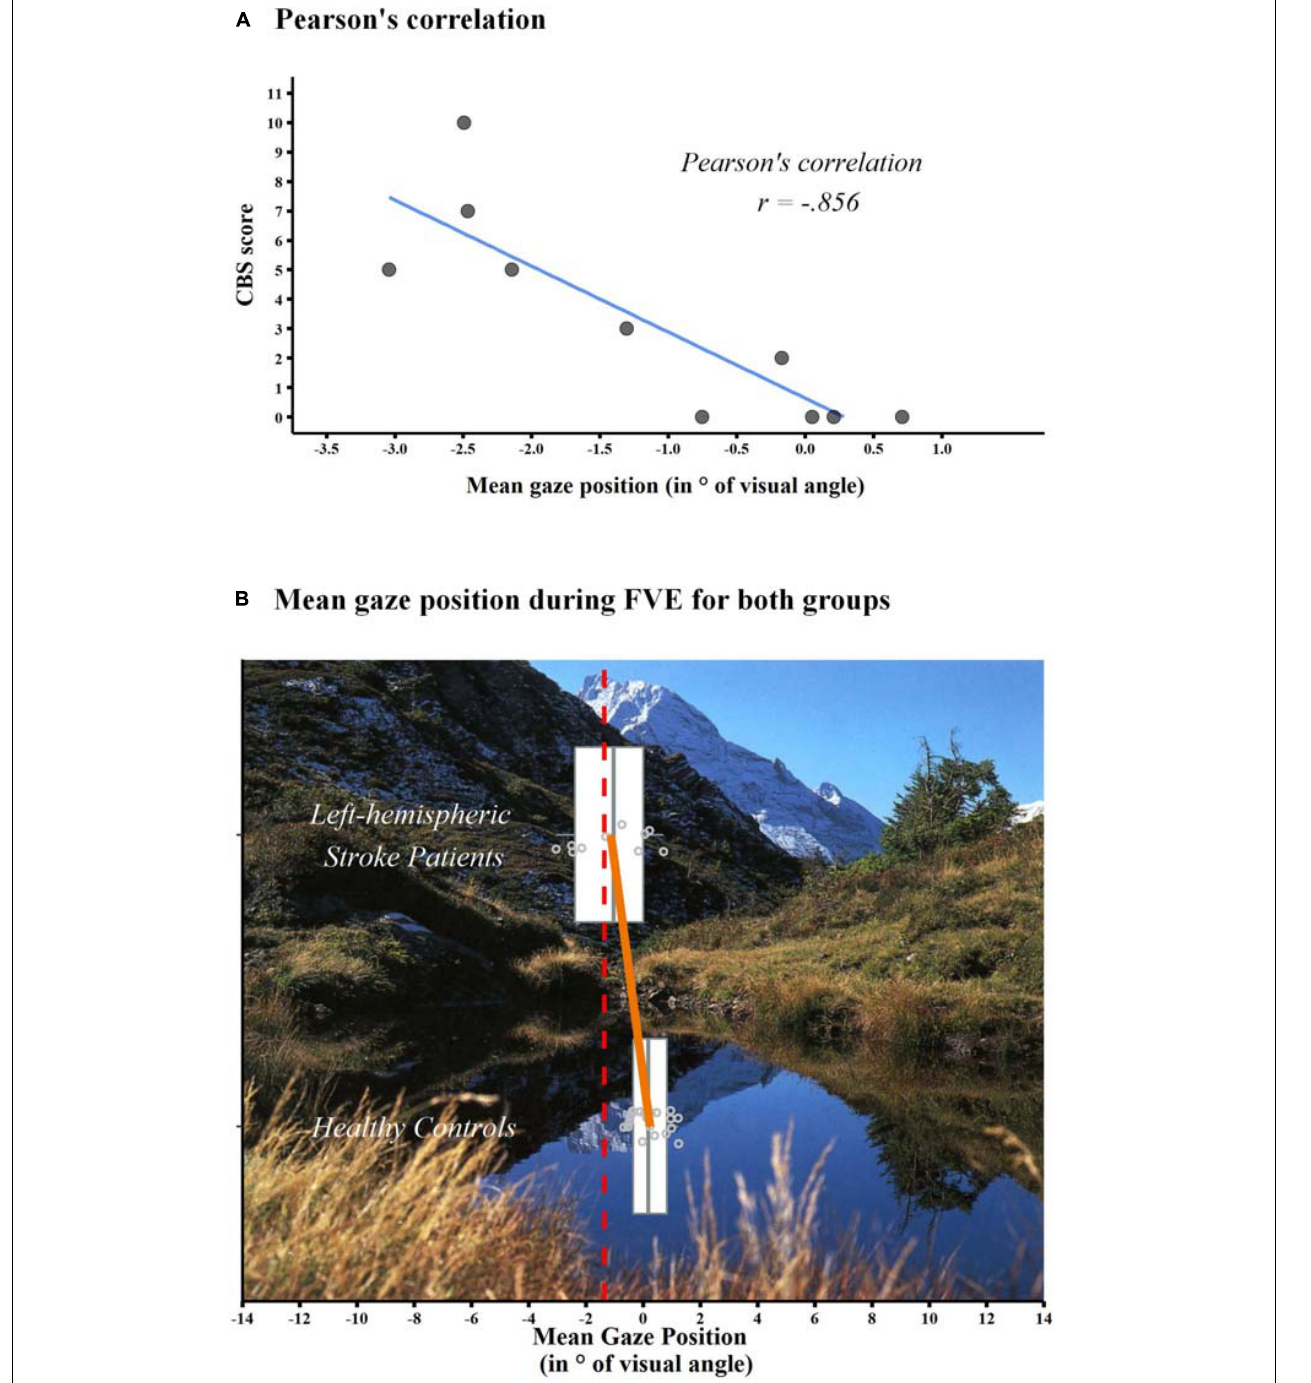
FIGURE 3 | (A) Depiction of the Pearson’s correlation between the mean gaze position during FVE and the CBS total scores in left-hemispheric stroke patients. The regression line is shown in blue. Grey dots represent the patients’ individual CBS total scores ( y -axis) and the corresponding mean gaze position during FVE in ◦ of visual angle ( x -axis; negative values representing a left-ward shift in exploration behaviour). (B) Box-and-Whisker plots of the Mean Horizontal Gaze Position (in ◦ of visual angle) in left-hemispheric stroke patients ( n = 10, top) and healthy controls ( n = 20, bottom). Each box represents the lower (Q1) to the upper (Q3) quartiles, with whiskers extending to the minimum and maximum of 1.5 times the interquartile range; the grey vertical lines represent the median. Additionally, mean values of the two groups are indicated by the endpoints of the orange line, and individual values by grey dots. The red, dashed line indicates the cut-off for